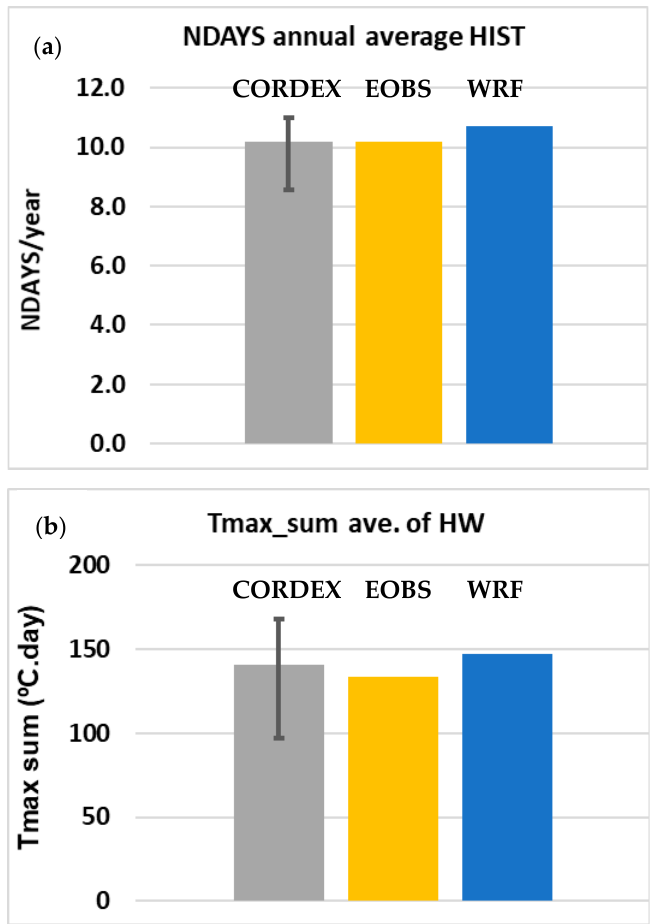
Figure 6. ( a ) NDAYS annual average and ( b ) Tmax_sum HW average for EOBS, WRF CORDEX average, maximum and minimum (vertical bar) for HIST BC. NDAYS: Number of HW days.